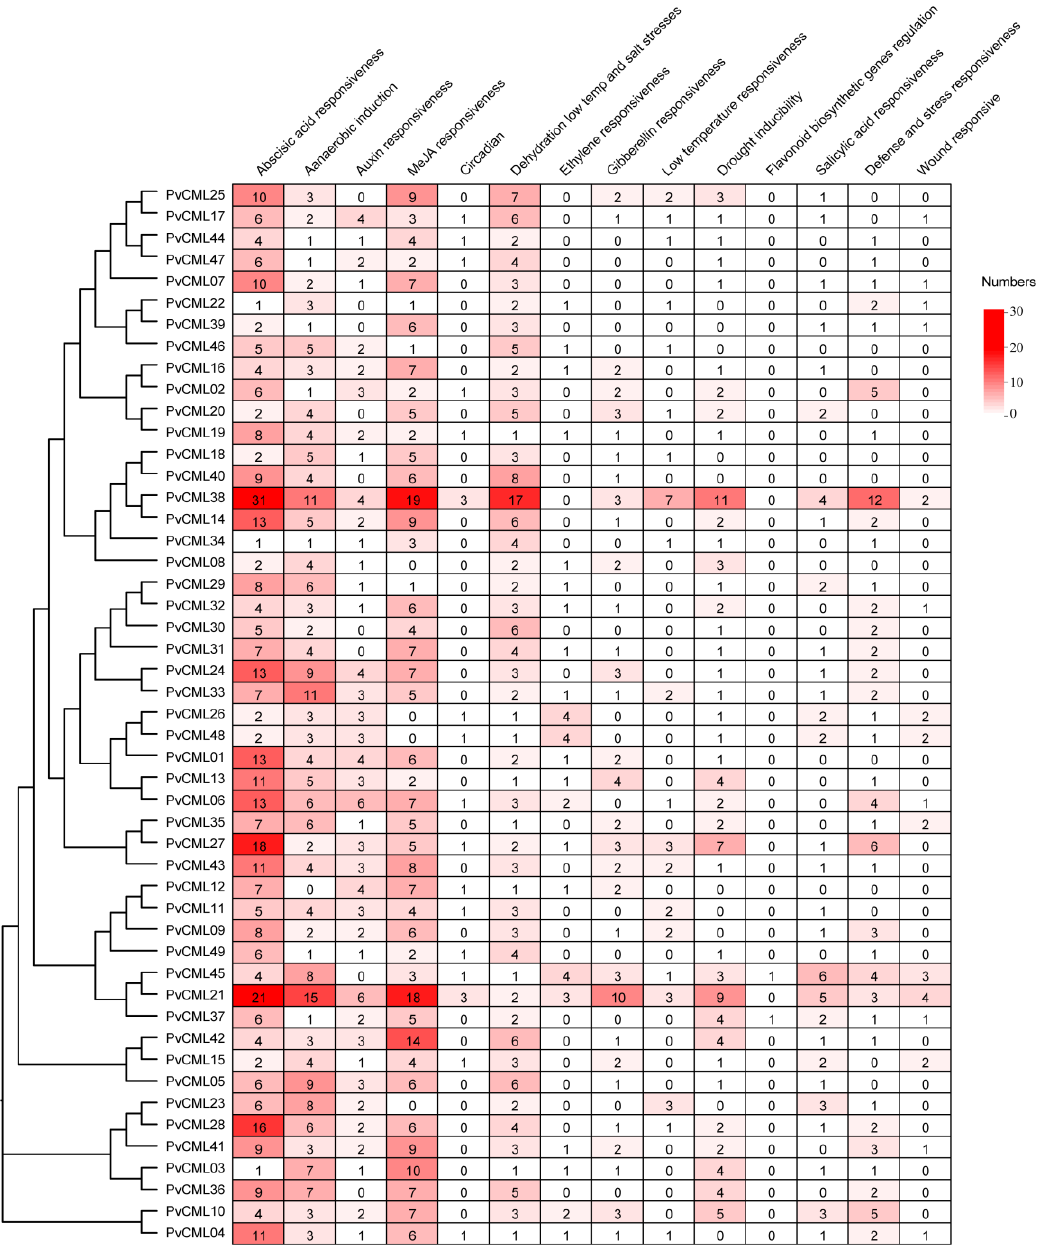
Figure 5. Prediction of cis-acting elements contained in PvCMLs. Analysis of cis-elements was carried out by the PlantCARE database. The analysis showed the presence of 14 cis-elements. The different colors represent the different numbers of cis-elements, with red indicating a high number of cis-elements, while white represents a low number of cis-elements. Values in the boxes represent the number of cis-regulatory elements.